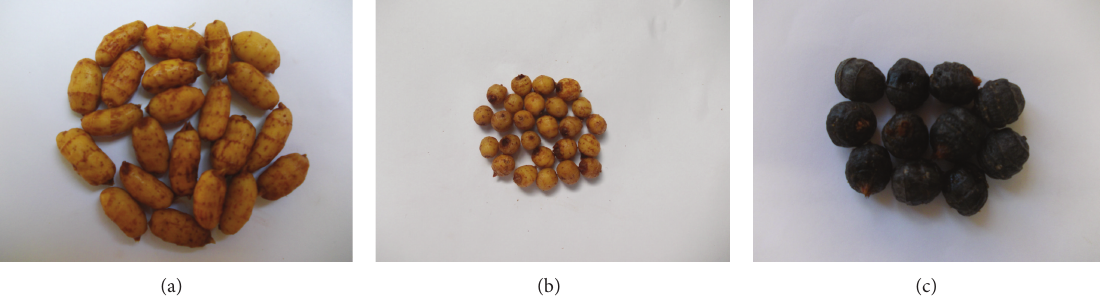
Figure 1: Morphotypes of Cyperus esculentus grown in Burkina Faso. (a) Morphotype 1: big size and yellow color. (b) Morphotype 2: small size and yellow color. (c) Morphotype 3: big size and black color. Table 1: Physical characteristics and proximate composition of Cyperus esculentus morphotypes tubers. Parameters